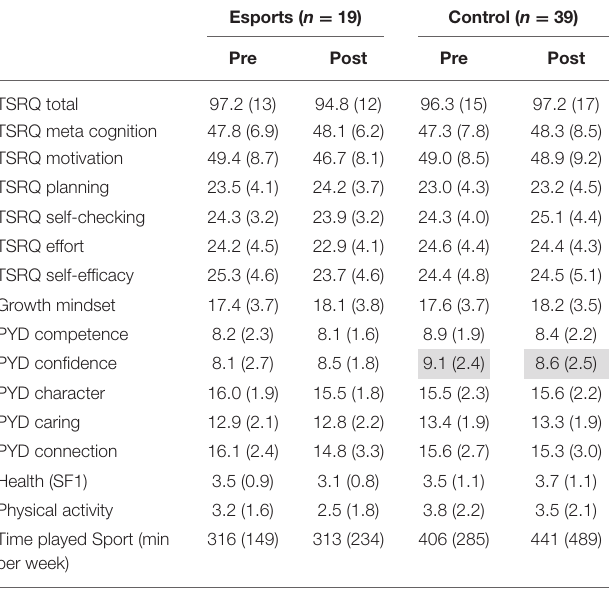
TABLE 2 | Mean and standard deviation scores at baseline and